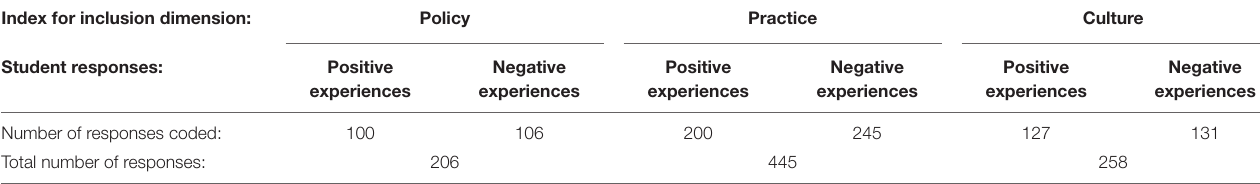
TABLE 2 | Number of student statements per